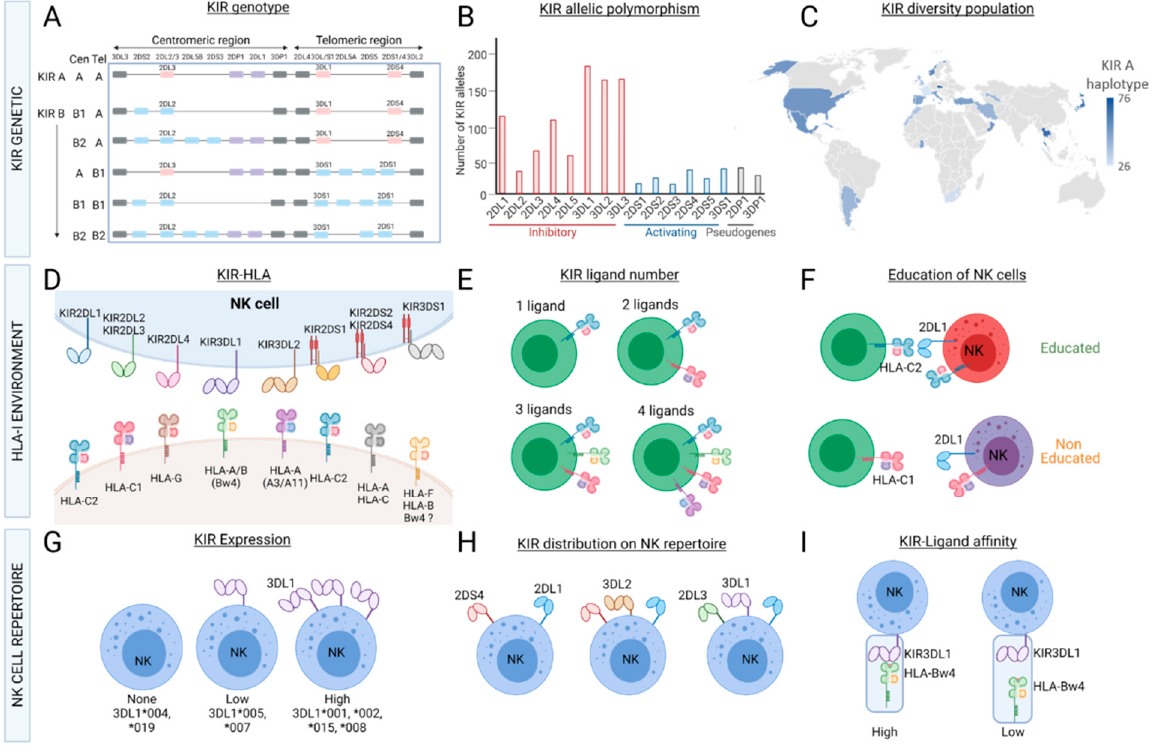
Figure 2. Variability of the KIR + NK cell repertoire. KIR genes (7–14) are located in the leucocyte region complex (LRC) on chromosome 19. Depending on the KIR gene content, different KIR haplotypes (A and B) and centromeric/telomeric motifs are defined ( A ). KIR genes exhibit an allelic polymorphism (https://www.ebi.ac.uk/ipd/kir/) (accessed date: 26, July, 2012). ( B ), and the diversity of KIR haplotypes and/or alleles can be observed worldwide (source provided by Dr J. Hollenbach from the 15th IHWG KIR component) ( C ). HLA class I molecules are ligands of KIRs ( D ). Depending on the typing of HLA-A, -B and -C, individuals can present from one to four KIR ligands ( E ). The HLA class I environment also play a major role in NK cell licensing ( F ). The allelic polymorphism of KIRs has an impact on the NK cell repertoire, as illustrated for the expression of different KIR3DL1 allotypes ( G ). KIRs are clonally distributed on NK cells; thus, the heterogeneous repertoire of NK cell subsets is based on the expression of different combinations of KIRs with different frequencies ( H ). The functions (cytotoxicity, cytokine production) of KIR + NK cells and KIR/KIR ligand affinities ( I ) could be affected by both KIR and HLA class I polymorphisms.